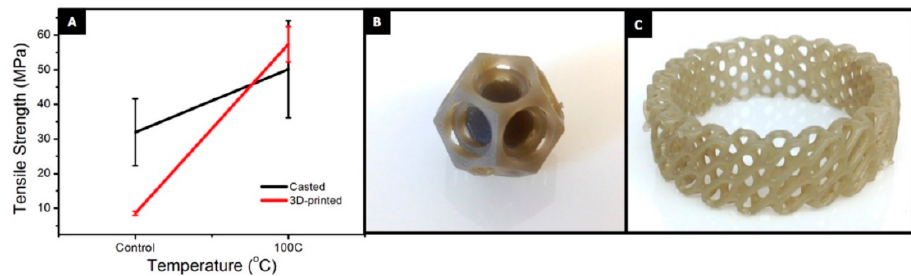
Figure 4. ( A ) Tensile strength comparison of casted and 3D-printed part. SLA-printed complex- shaped GO nanocomposites: ( B ) nested dodecahedron and ( C ) diagrid ring. Reprinted with permis- sion from [111].